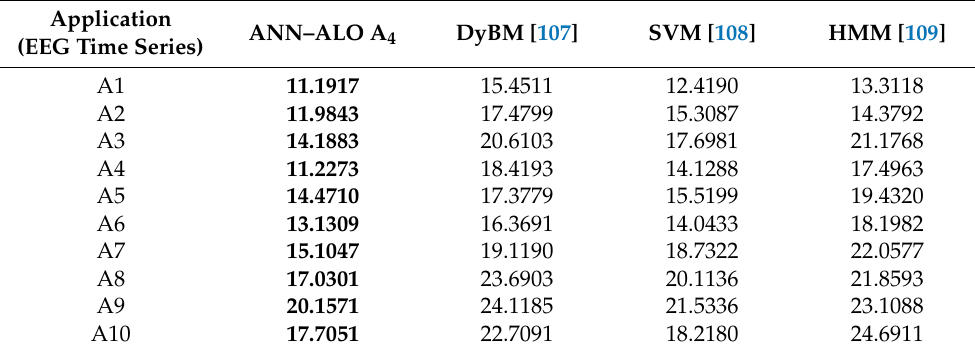
Values represent the mean MAE from 30 runs. Best values are in bold style. Table 10. Mean MAE values of predictions done for the EEG time series using ANN–ALO A 4 and some other prediction approaches (set 2).